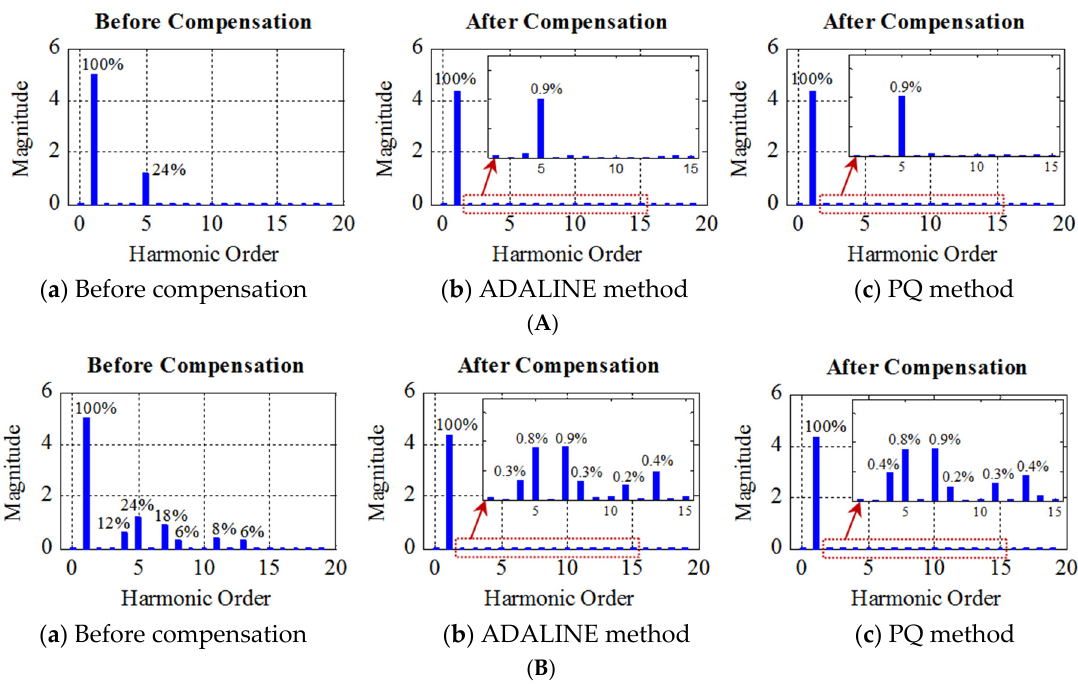
Figure 9. Spectrums of the source current for Case 1: ( A ) Spectrums at intervals 0 ≤ Time < 0.25 s; ( B ) Spectrums at intervals 0.25 ≤ Time < 0.5 s.